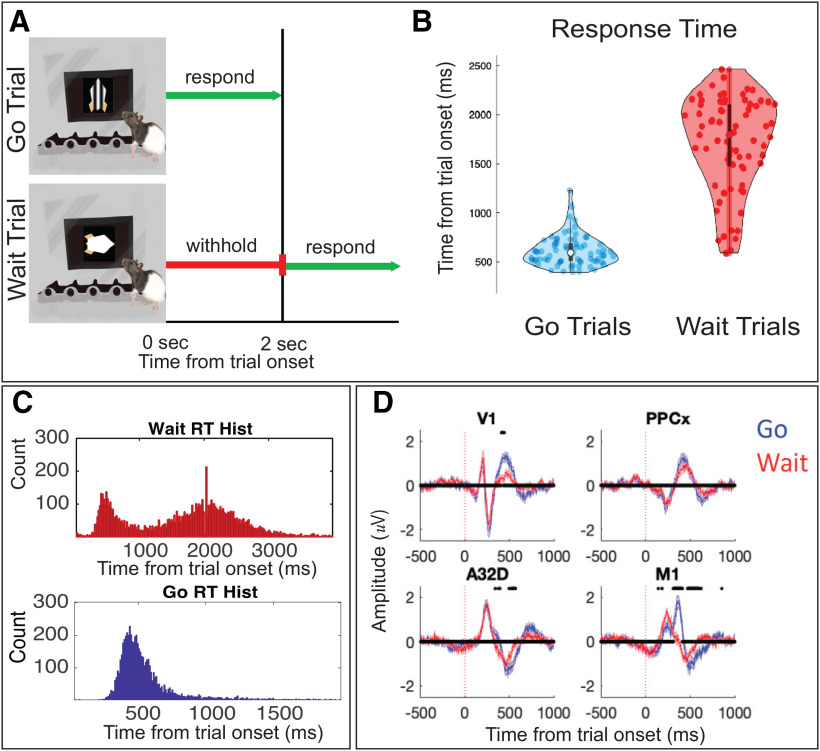
Task design and electrophysiological approach. A, The behavioral paradigm we used consisted of a visual stimuli instructing animals to respond immediately (go trial, denoted with an upward-facing striped rocket) or after specified delay (wait trial, denoted with a horizontal-facing white rocket). On go trials, animals had to respond within 2 s to earn a reward (20 μl of water). On wait trials, animals had to wait 2 s and then respond to collect a reward. B, A violin plot representation of the RT for go and wait trials across behavioral sessions (single dots represent individual behavioral sessions across 60 sessions). Animals could distinguish visual stimuli and showed appropriate behavior (waiting longer on wait compared with go trials). C, Histogram of all trials (from all sessions), demonstrating the difference in reaction time for wait and go trials, showing clear discrimination and attempts to wait. D, Average event-related potentials (ERPs) from a few selected brain regions: V1, M1, PPCx, and dmPFC from go and wait trials (n = 60 sessions). Data were broad-band filtered (0.5–500 Hz), and baseline normalized before averaging. Shaded-error plots show mean/SEM. There are significant differences between ERPs for go (blue) and wait (red) trials; *significant differences at p < 0.05, as estimated using a paired t test, followed by FDR-correction performed across the entire 2D time and electrode matrix. Extended Data Figure 2-1 shows preprocessing steps, number of trials/session, and a different view of electrode placement along histology.